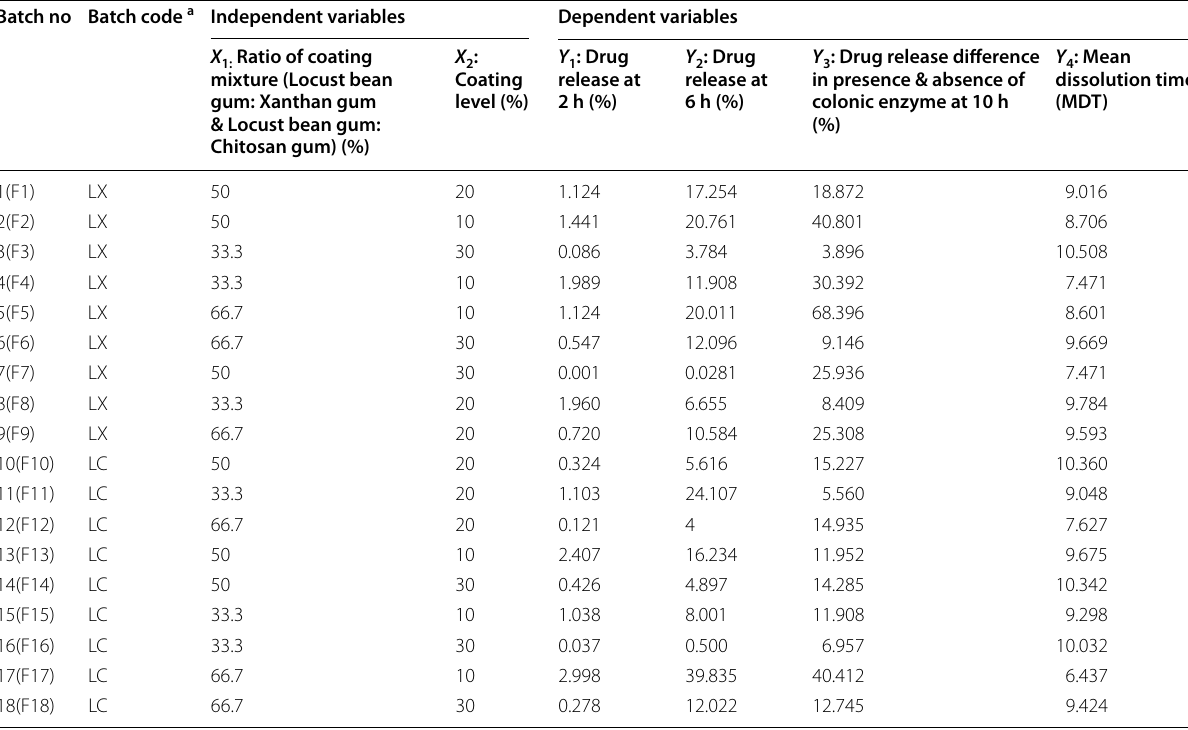
Table 2 Experimental formulation (Runs) and observed results from response surface